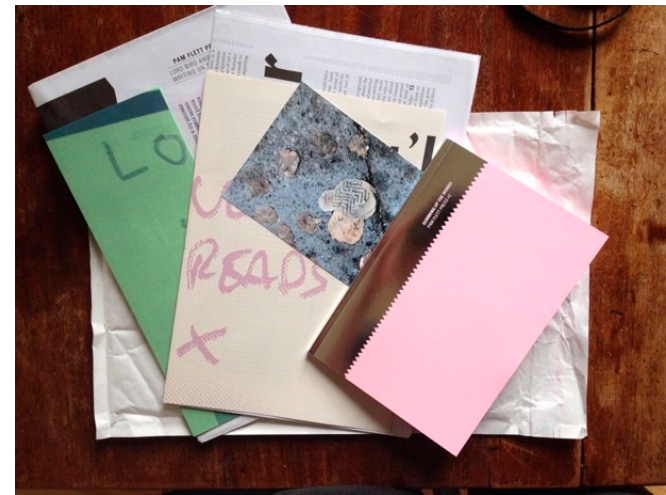
Figure 4. The Pam Flett Press by Joanne Lee. Photo by Joanne Lee. Used with permission.